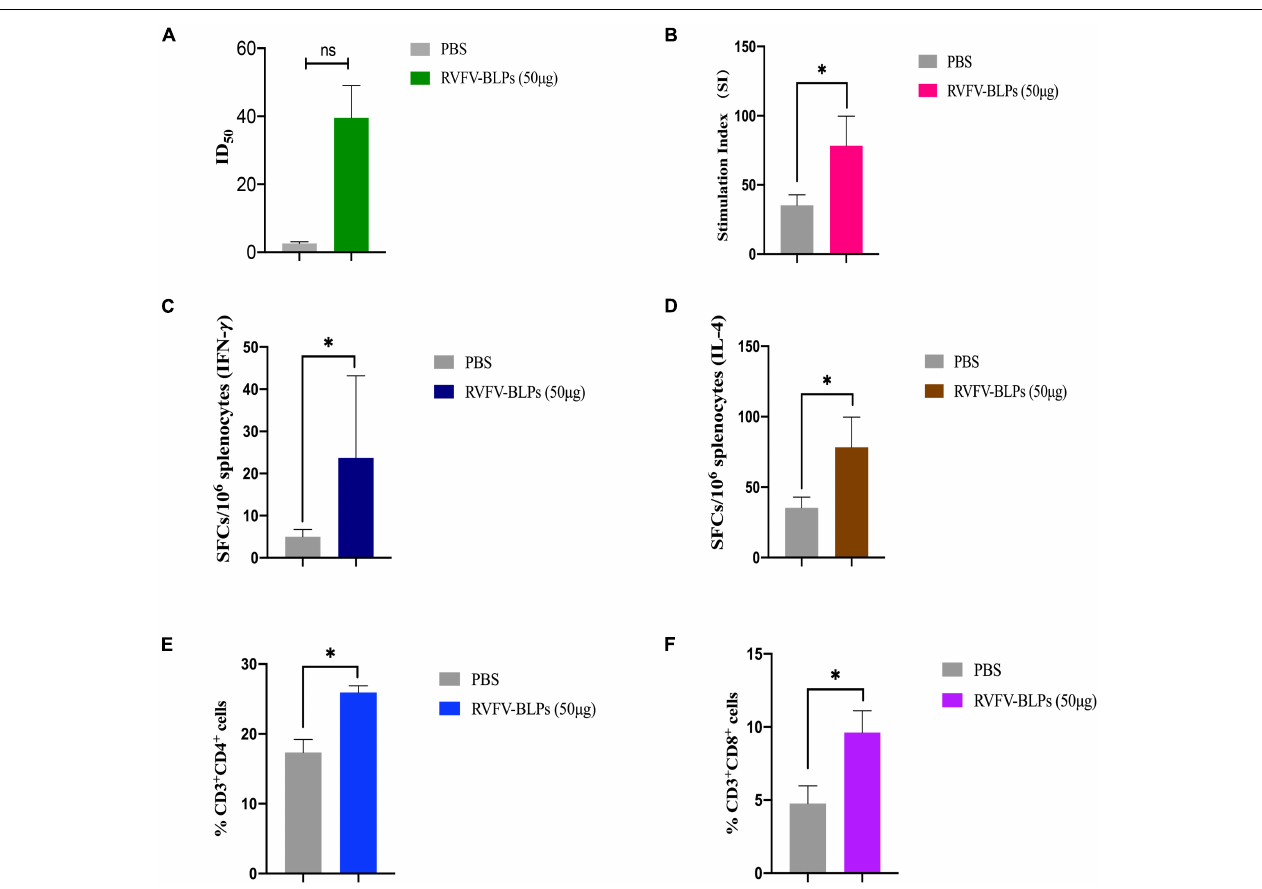
FIGURE 7 | Humoral and cellular responses detection of mice immunized with RVFV-BLPs (50 µ g). The neutralizing RVFV-pseudovirus activity of mice immunized with RVFV-BLPs (50 µ g) of 2 weeks after the third immunization were represented by 50% inhibition dilution (ID 50 ) (A) . Antigen-specific T cell proliferation, the stimulation index of the splenocytes was detected using a CCK assay by stimulating the cells with purified RVFV Gn head protein (B) . The RVFV Gn head-specific IFN- γ and IL-4 activity of splenocytes were evaluated using commercial ELISpot kits. SFC secreting IFN- γ (C) and IL-4 (D) were enumerated in an automated ELISpot reader. T cell proliferation was analyzed by using the following gating strategy: live rightarrow single cells rightarrow CD3 + → CD4 + /CD8 + (E,F) . Data are shown as the mean ± SEM and were analyzed by an unpaired t -test ( ∗ p <